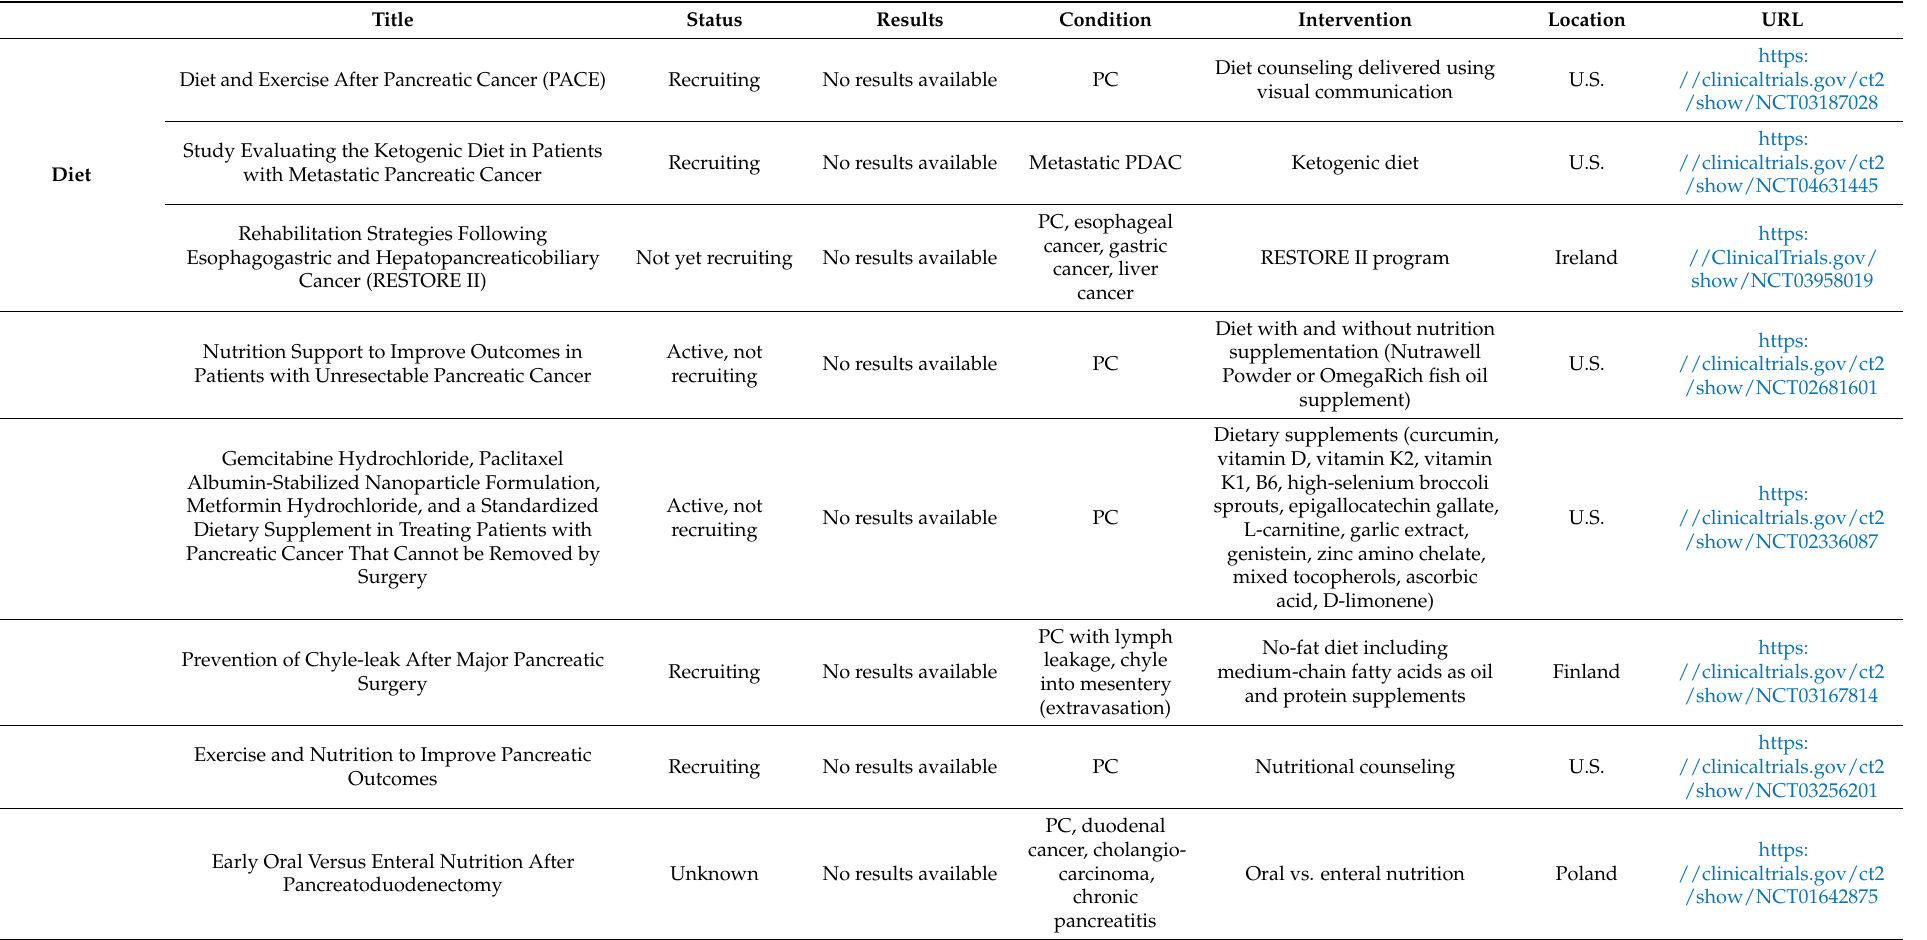
Table 2. Clinical trials registered on ClinicalTrials.gov (as accessed on 7 September 2021) concerning diet and fecal microbiota transplantation (FMT) as adjuvant therapy in pancreatic cancer patients. Search terms included “pancreatic cancer”, in combination with “diet” or “FMT”. Only the trials started no earlier than 2015 were considered. No results were returned when searching for